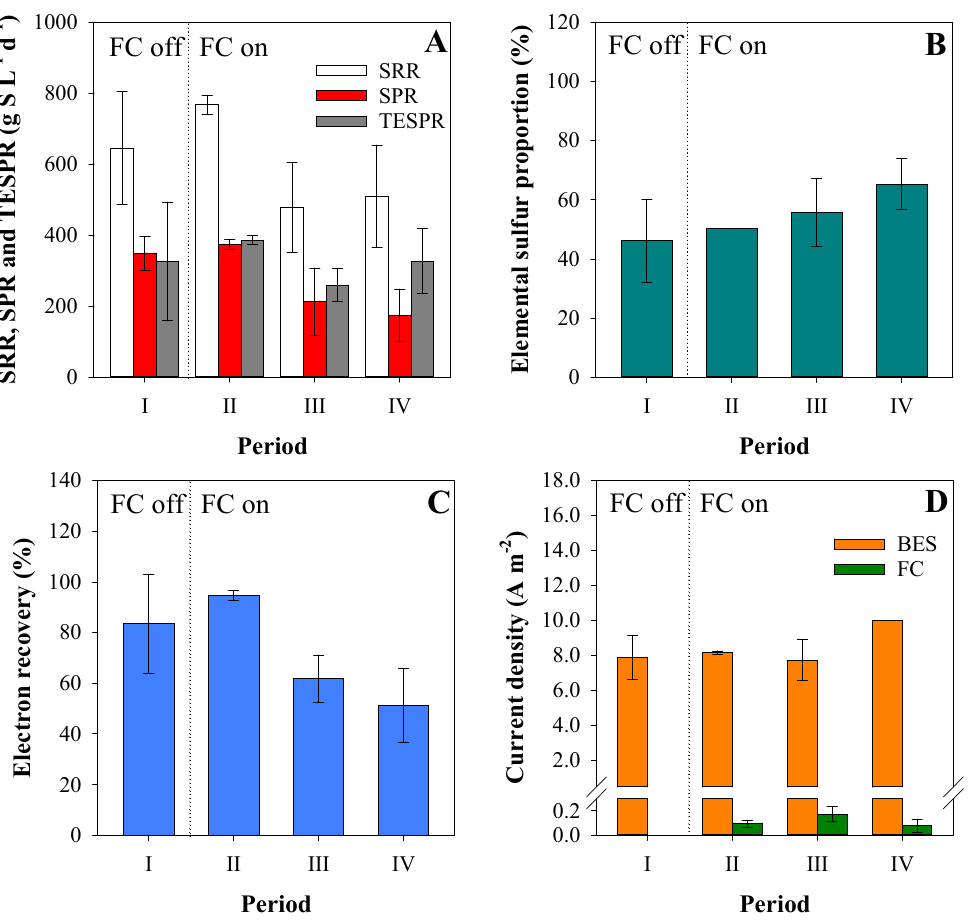
Figure 4. Average plots of the different operational phases of the BES-FC after the start-up on ( A ): sulfate reduction rate (SRR), sulfide production rate (SPR) and theoretical elemental sulfur production rate (TESPR), ( B ): elemental sulfur proportion in relation to sulfate reduced, ( C ): electron recovery as sulfate reduced in the biocathode and ( D ): current density of BES and FC.